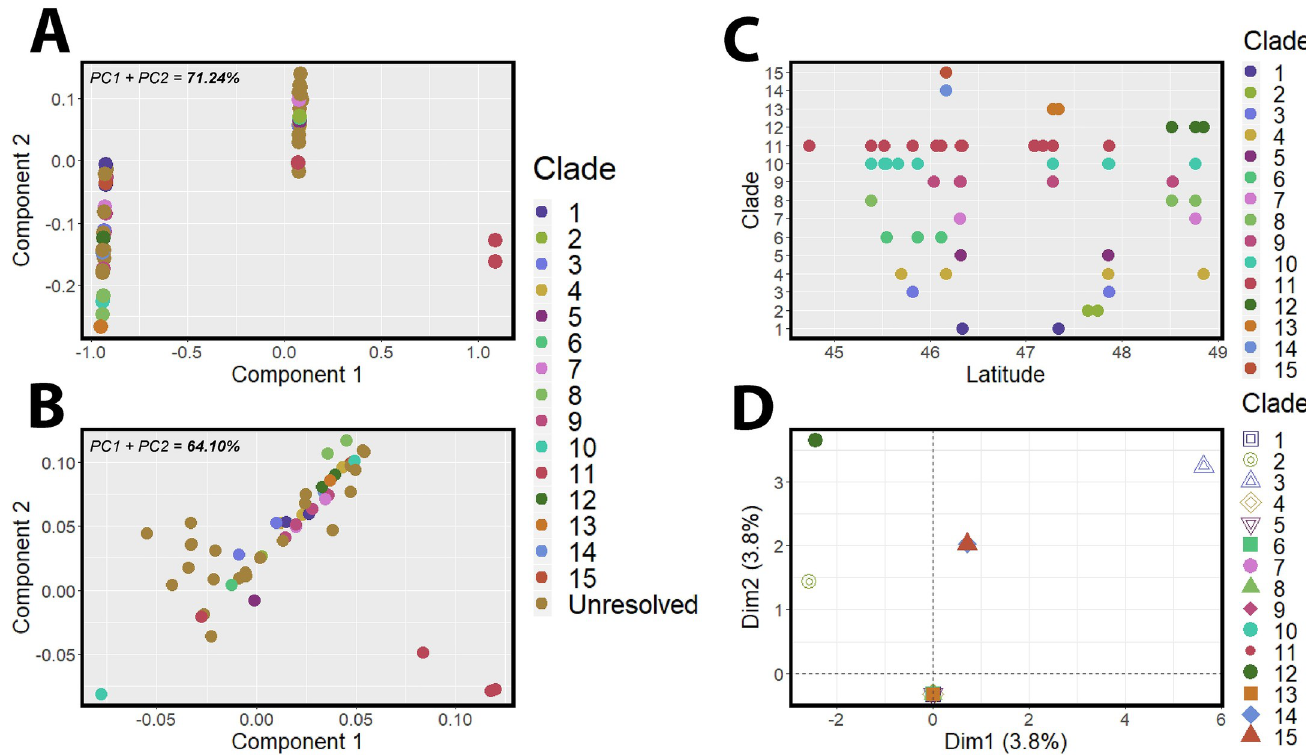
Fig 2. Principle components analysis (PCoA) of the PNW GAPDH RAxML phylogeny revealed three distinct isolate clusters, with clade 11 segregating as a separate cluster from the remaining PNW collection (A). A PCoA of the PNW GAPDH alignment also revealed three distinct clusters, with clades 10 and 11 segregating from the remaining PNW collection (B). A scatterplot of clade versus latitude did not reveal distinct patterns within the larger groups of the PNW collection (C), and a multiple components analysis showed some differentiation with clades 3, 12, 14, and 15 from the remaining PNW isolate collection, but revealed weak associations overall between latitude, isolate clade, and phylogenetic differentiation